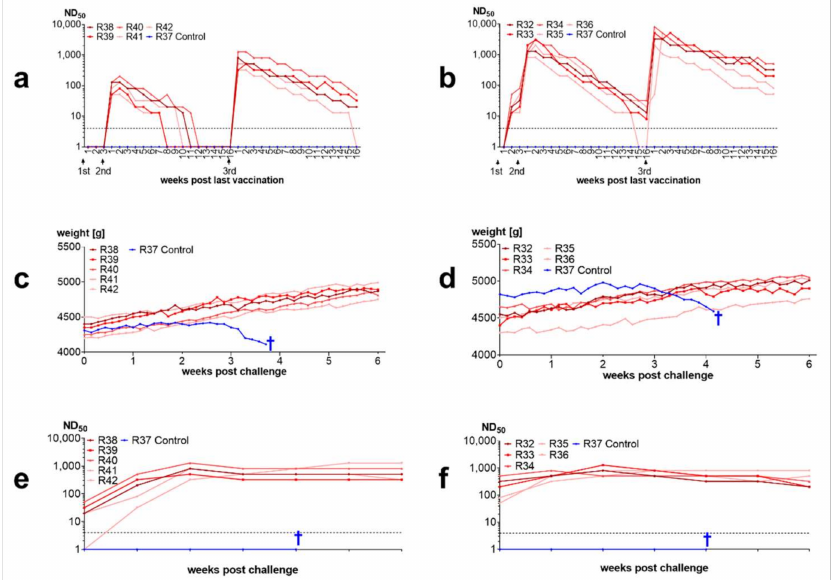
Figure 8. NT antibody kinetics in rabbits after vaccination with inactivated vaccines based on BoDV-1 strain V/B, following three doses of nonadjuvanted vaccine ( a ) or of ISA25-adjuvanted vaccine ( b ). Body weights after challenge with BoDV-1 V/B in animals vaccinated with nonadjuvanted inactivate ( c ) and in the animals vaccinated with ISA25-adjuvanted inactivated vaccine ( d ). NT antibody titers [ND 50 ] in the nonadjuvanted group after challenge infection ( e ) and in the ISA25-adjuvanted group after challenge infection ( f ). Dashed lines, IF and NT assay limits of detection; †, animal euthanized before succumbing to lethal illness.